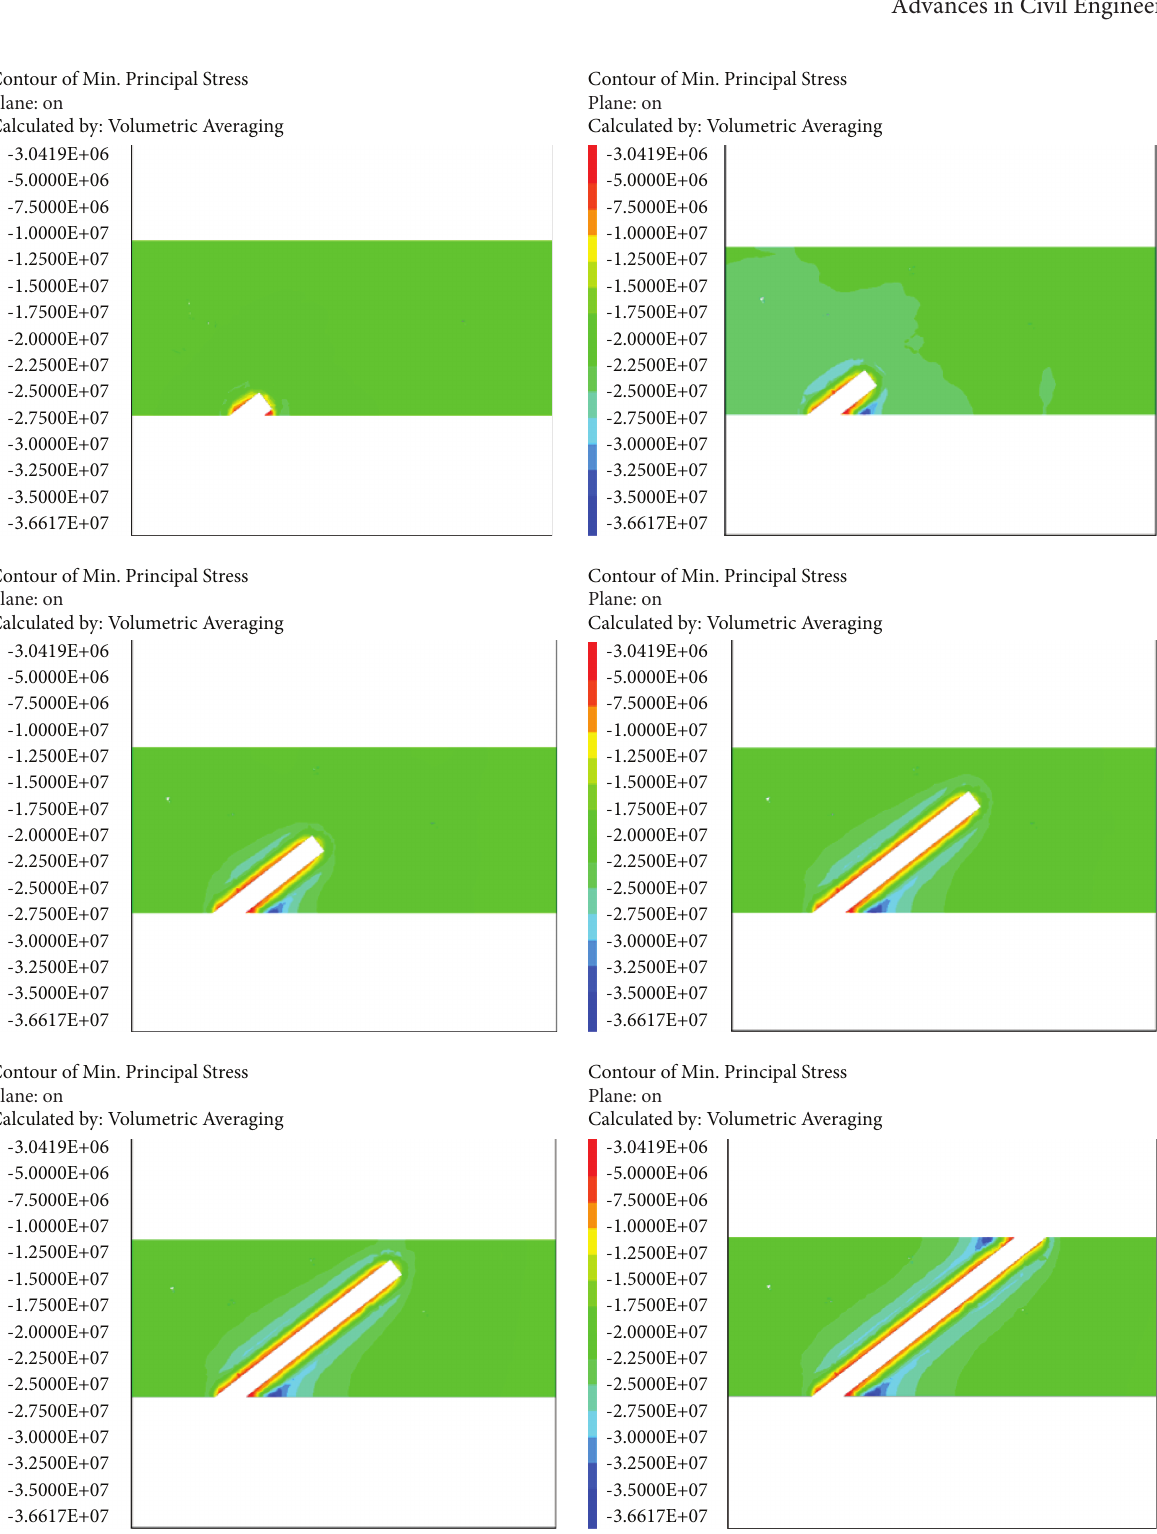
Figure 17: The maximum principal stress distribution cloud chart of